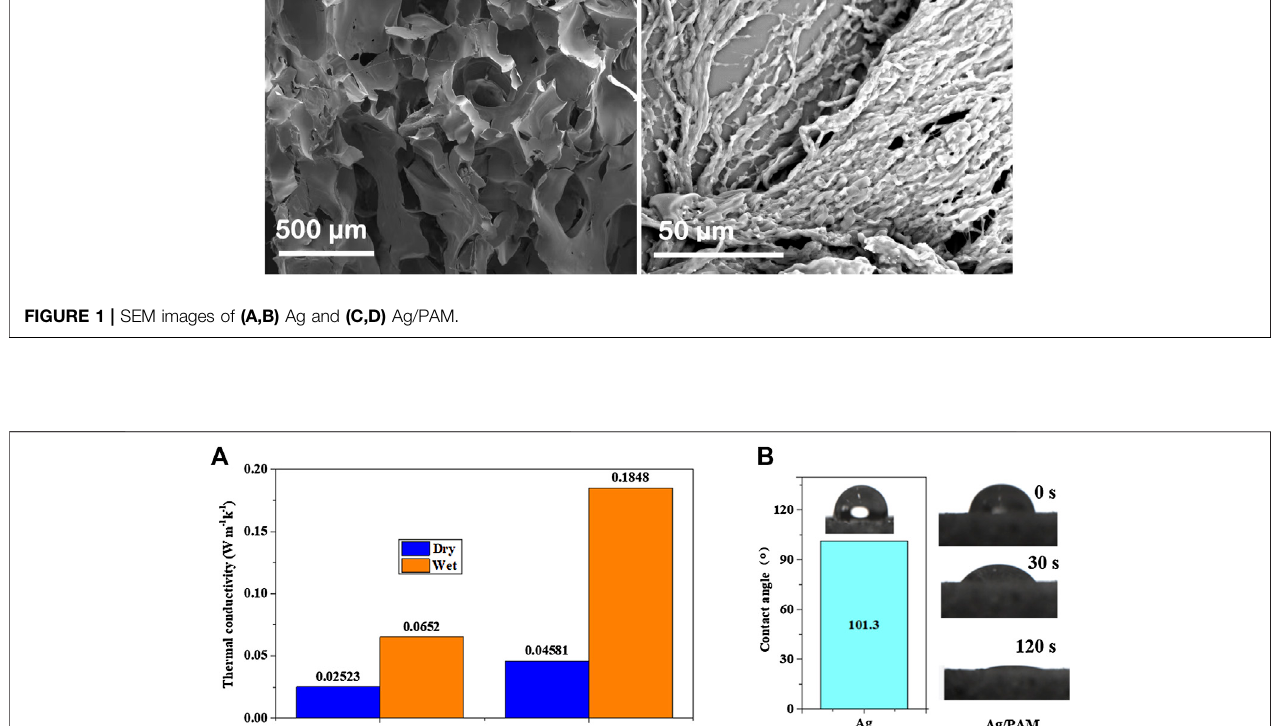
Standardization Organization (ISO), where Ts is calculated according to statistical methods using the formula T s = 0.49